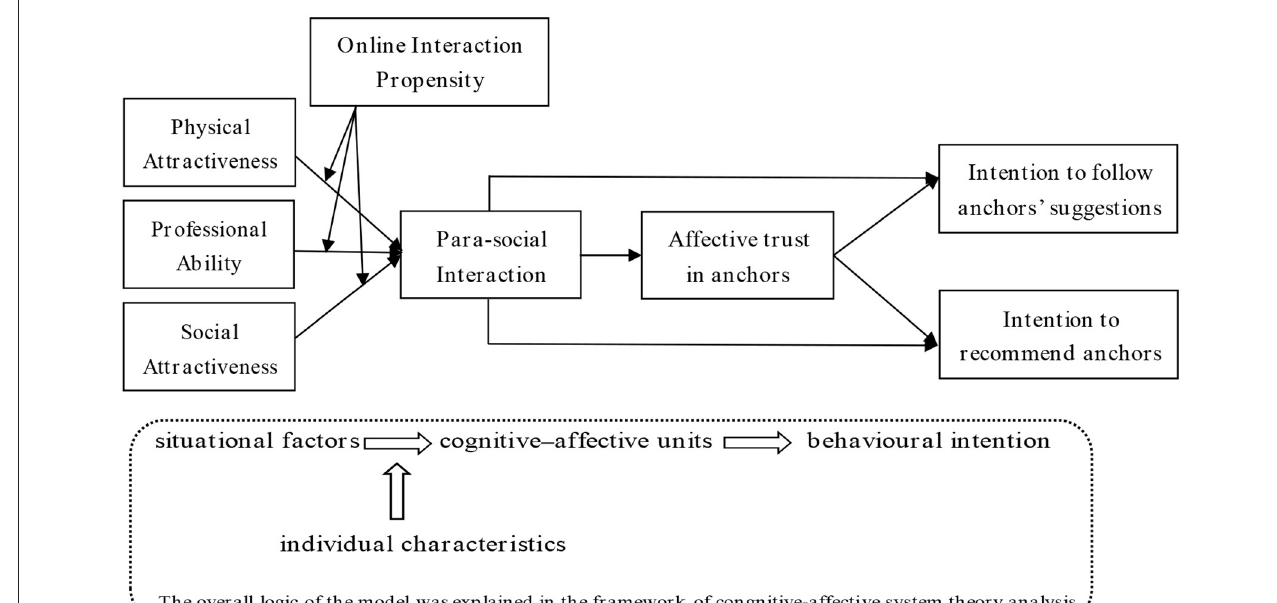
FIGURE 1 | Theoretical